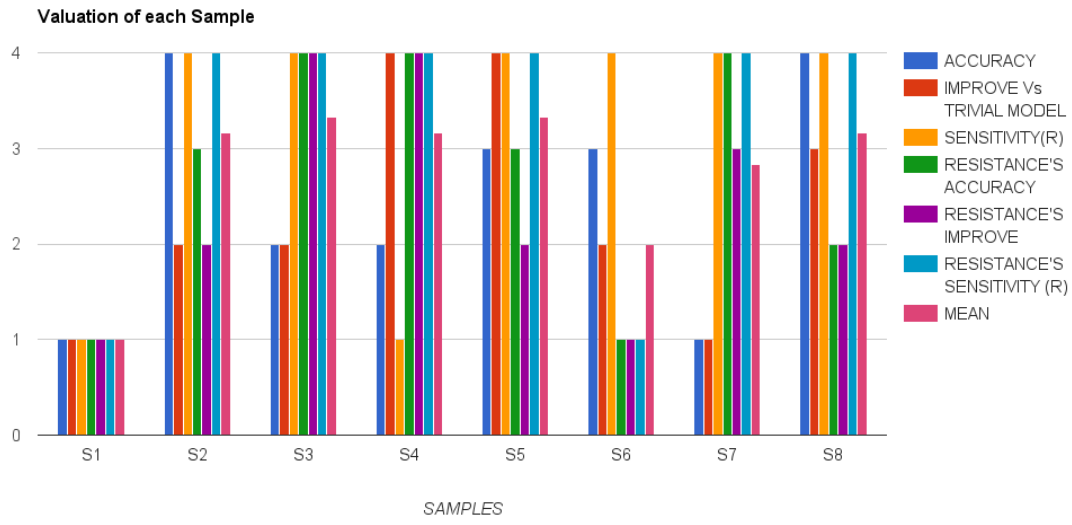
Fig. 6. Quantized values of accuracy and resistance accuracy, improvements over trivial model, and sensitivities